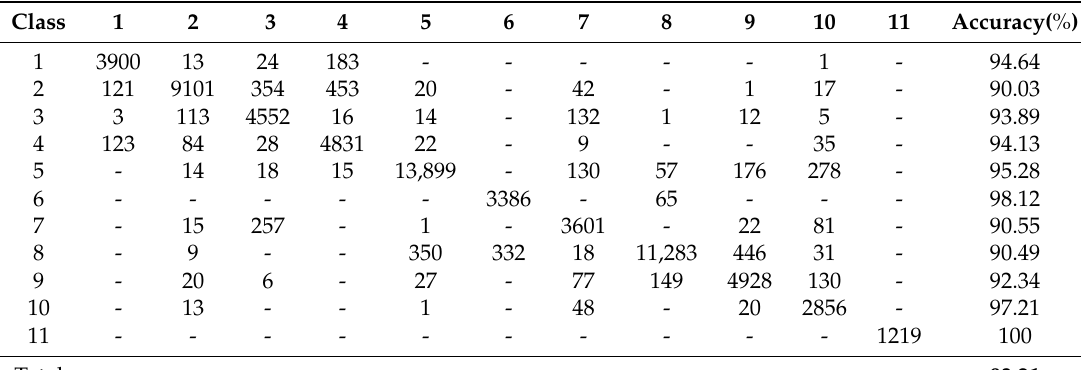
Table 4. Confusion matrix for Flevoland I data using